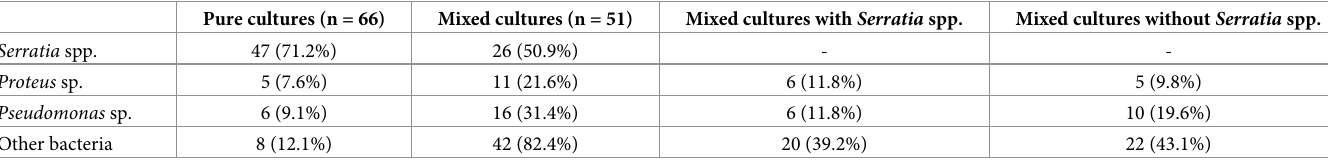
Table 1. Bacteriological isolation rates from insect haemolymph samples. Pure cultures (n = 66) Mixed cultures (n = 51) Mixed cultures with Serratia spp. Mixed cultures without Serratia spp. Serratia